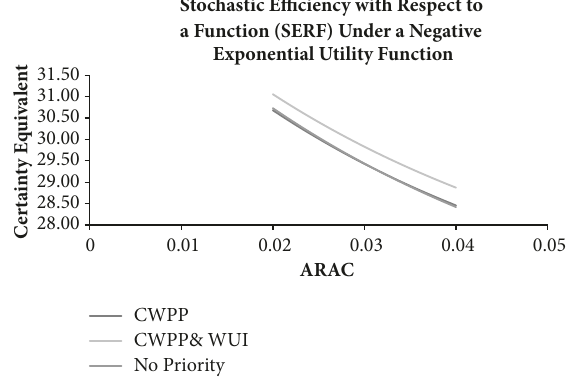
Figure 2: Plot of CE values for Plum Creek for weight scenario PC1 and ARAC interval [ .02,